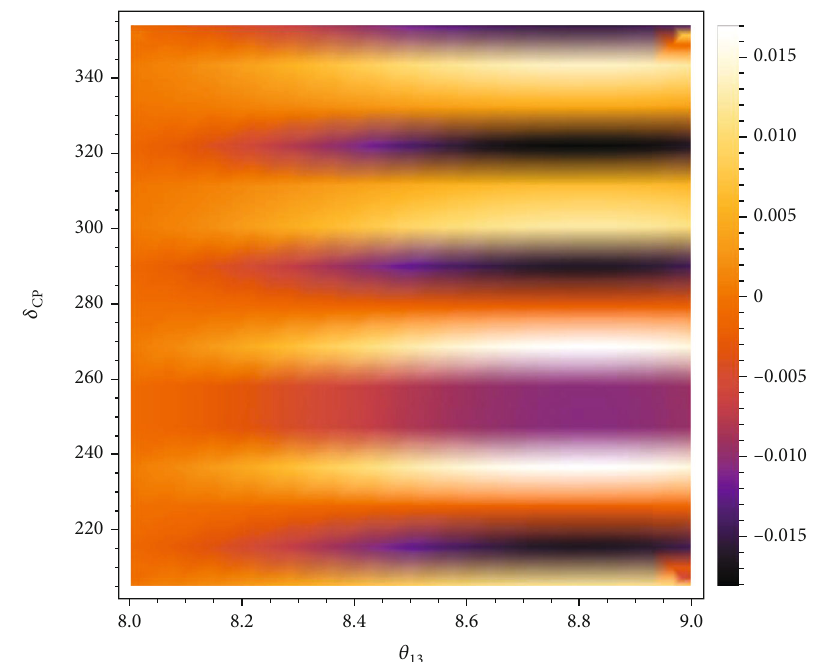
Þ for values of , m CP 3 = 8 : 49 ° corresponding to Δχ 2 = 9 : 5 13